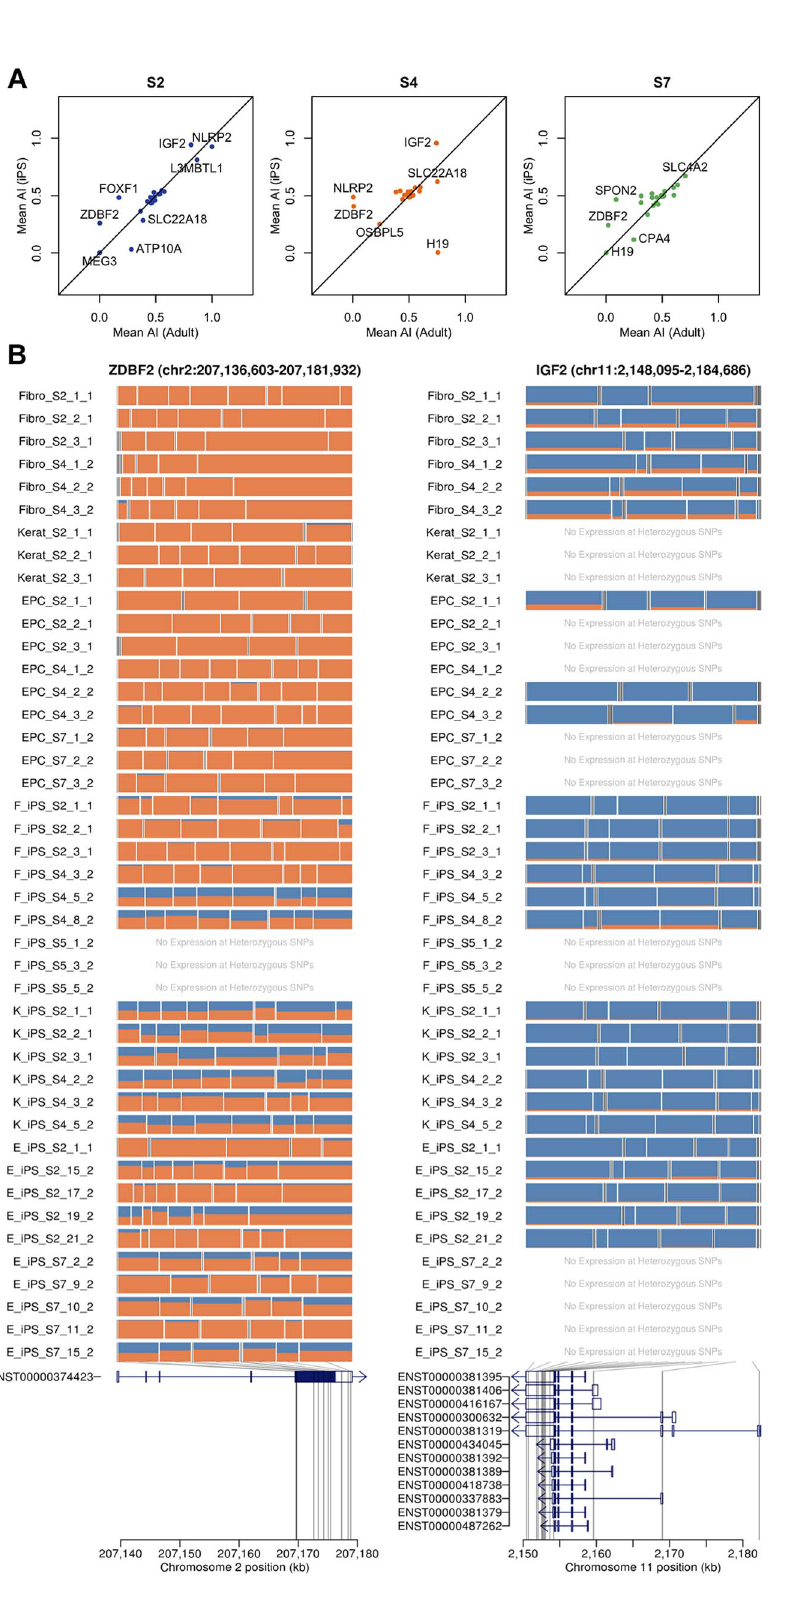
PLOS Genetics | www.plosgenetics.org